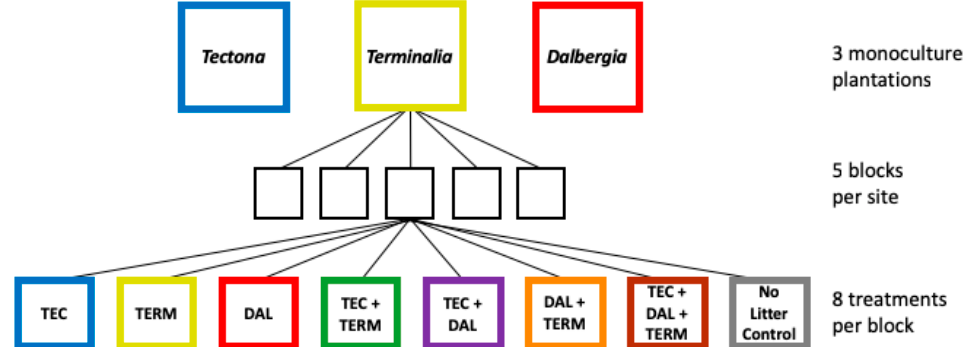
Figure 1. Schematic diagram showing the design of a litter mesocosm experiment in tropical timber plantations in Panama, Central America; the top row of boxes represents three monoculture plantations; in each plantation there are five replicate blocks (centre row), and in each block there are mesocosms with one of eight treatments (bottom row) including single-species litter and all two-and three-species mixtures, as well as a bare soil control without litter, where TEC is Tectona grandis , TERM is Terminalia amazonia and DAL is Dalbergia retusa litter.